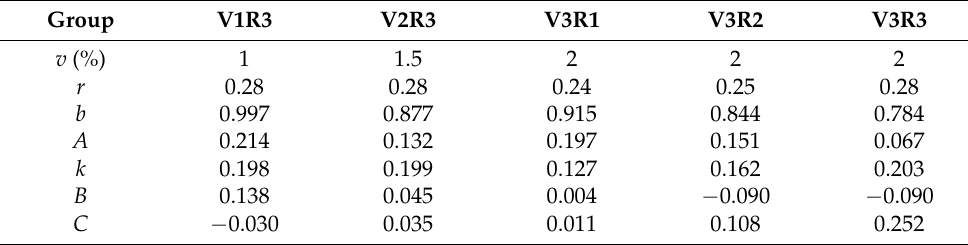
Table 4. Damage model